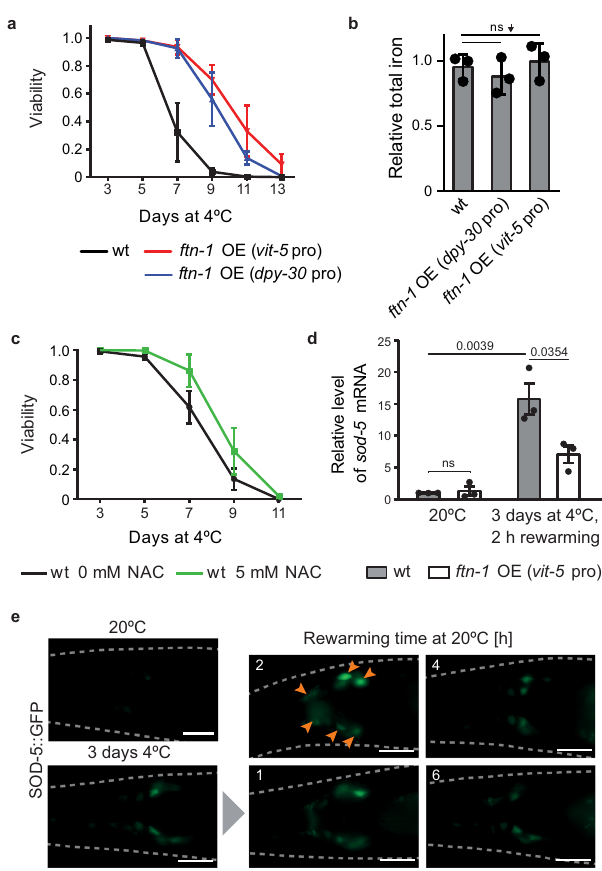
Fig. 7 | FTN-1 overexpression is suf fi cient for enhanced cold survival. a FTN-1 overexpression (OE) increases cold resistance. Cold survival was compared betweenwt, ftn-1 OE (vit-5 pro ) ,and ftn-1 OE (dpy-30 pro ) animals, as in Fig. 1a( dpy- 30 pro ( sybSi67) and vit-5 pro ( sybSi72) indicate OE lines, with ftn-1 gene under control of dpy-30 or vit-5 promoter). Error bars represent SEM, n =3 independent experiments. 232 – 307 animals scored per time point. b Total iron is unaffected by FTN-1 overexpression. One-day-old animals, as in a , were grown at 20°C, and total ironinextracts was measured and analyzed as inFig. 6a,with values normalized to wild type. Error bars indicate SEM, n =3 independent experiments. ns not sig- ni fi cant(unpairedtwo-sided t -test). c Antioxidanttreatmentimprovescoldsurvival of wild-type animals. Cold survival was compared between wt incubated in the absence or presence of N -acetylcysteine (NAC, 5mM), as in Fig. 1a. Error bars represent SEM, n =4 independent experiments. 452 – 514 animals scored per time point. d FTN-1 overexpression reduces sod-5 mRNA elevated during rewarming of cold-exposed nematodes. One-day-old animals, wt or ftn-1 OE (vit-5 pro ) , were collectedat20°Corafter3daysat4°Cwith2hofrewarmingat20°C.Thelevelsof sod-5 mRNA(normalizedto act-1 mRNA)weremeasuredbyRT-qPCRandexpressed relative to wt at20°C. Error bars represent SEM, n =3 independent experiments. p values calculated using unpaired two-sided t -test; ns not signi fi cant. e The expression of SOD-5::GFP peaks during rewarming. Representative fl uorescence micrographs showing the expression of SOD-5::GFP fusion protein in the head region in 1-day-old adults subjected to cold. The animals were cold-exposed for 3days,transferredbackto20°C,andexaminedduringrewarminginatime-course fashion. Representative images were taken at the indicated times and tempera- tures. Animals are outlined with gray, dashed lines. The experiment was repeated two times, with similar results. Scale bar: 20 µ m. Source data are provided as a Source Data fi